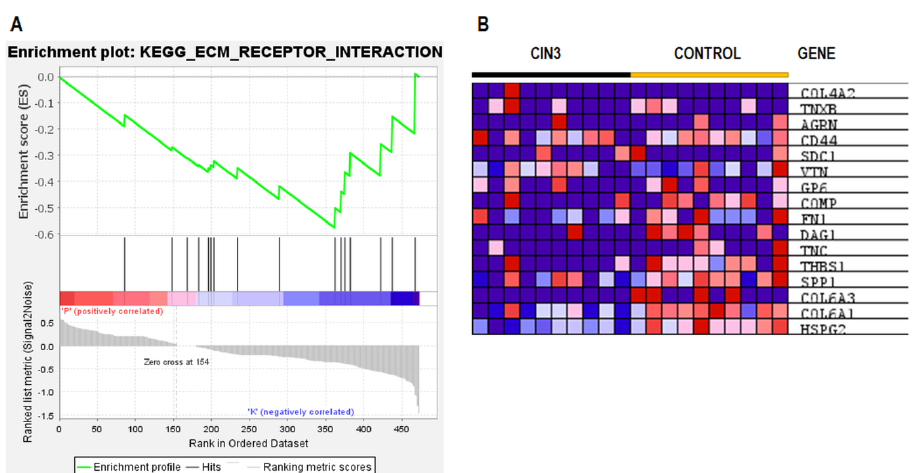
Figure 4. GSEA analysis of the whole, quantified proteins between the CIN3 patients and the healthy control groups. ( A ) Enrichment plot: KEGG ECM-receptor interaction (NES = − 1.64, p = 0.026). ( B ) Heatmap of core enrichment genes in the gene set of the ECM-receptor interaction. Expression values are represented as colors, where the range of colors (red, pink, light blue, and dark blue) represent the range of expression values (high, moderate, low, and lowest).